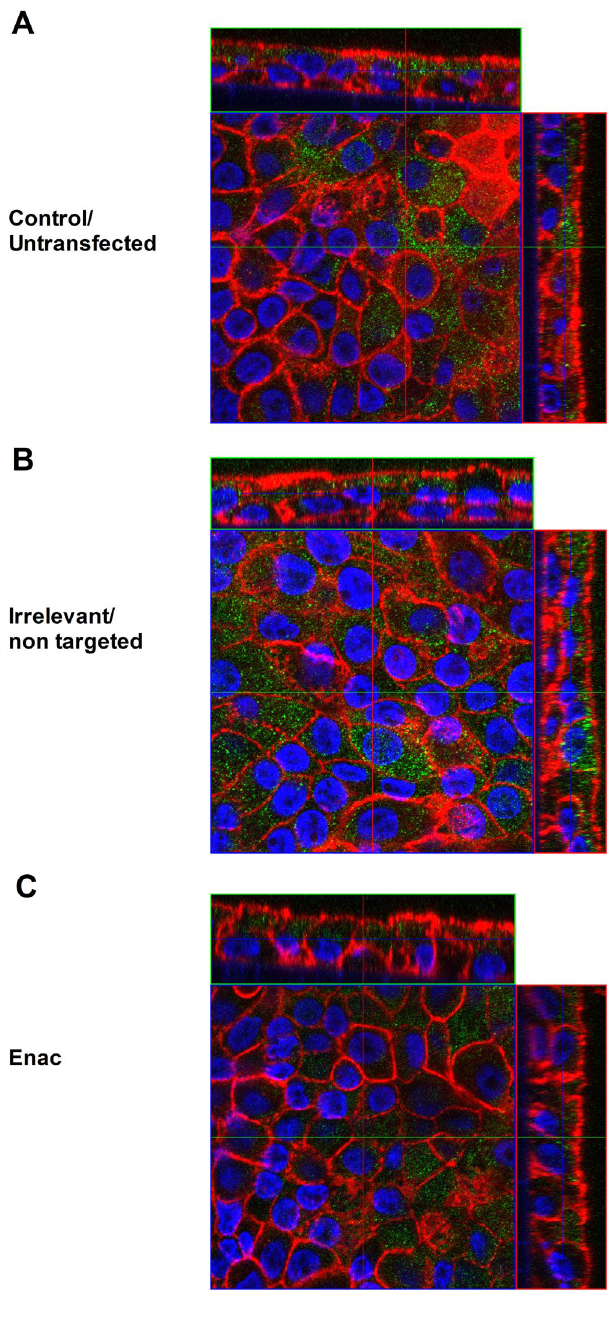
Figure 5. Confocal images of primary cells transfected with peptide E nanoparticles. Confocal images of NHBE cells grown in transwells and stained for α -ENaC (green), actin (red) and DAPI (blue) to label the nuclei; ( A ) untransfected control ( B ) non-targeting/irrelevant siRNA-treated and ( C ) α -ENaC siRNA-treated. The narrow panels on top and on the right side represent the cross-sectional view related to the indicated